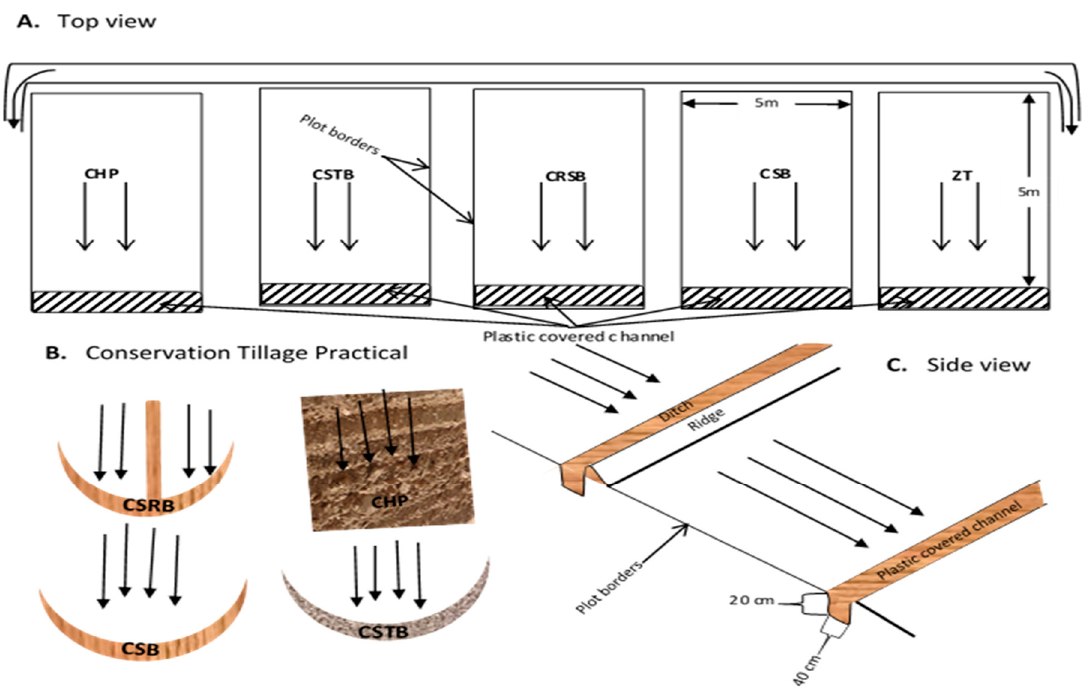
Figure 4. The field layout of the simple methodology to determine the effect of conservation tillage on soil erosion. Chisel ploughing, CHP; cross slope tied bonding, CSTB; contour ridge with stone bonds, CRSB; cross slope bonding, CSB; and zero tillage, ZT. Arrows are in the flow direction.